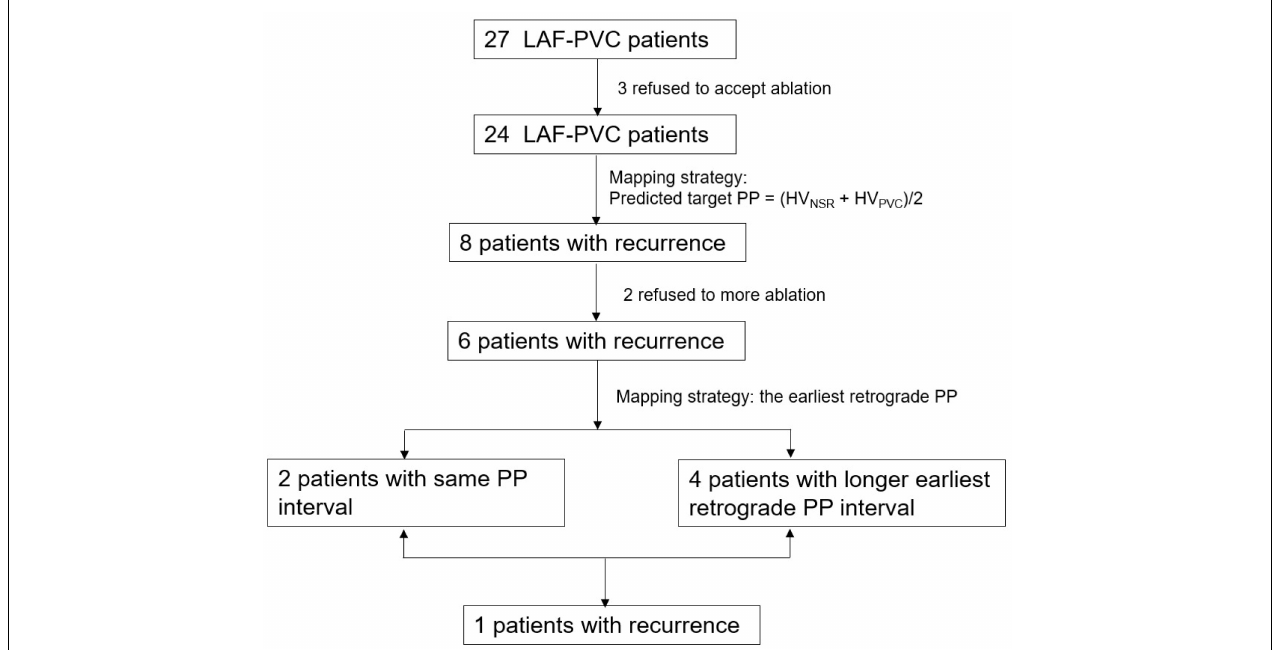
FIGURE 1 | A flowchart of the study population. PVC, premature ventricular contractions; LAF, left anterior fascicle.